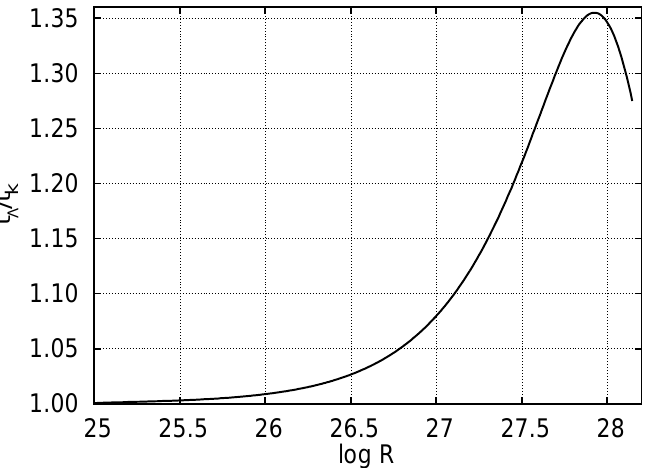
Fig. 2b. The ratio of ages of the above described flat and hyperbolic model universes versus log R . The difference appears starting at z < 100. energy relative to the potential energy of the matter and radiation in the